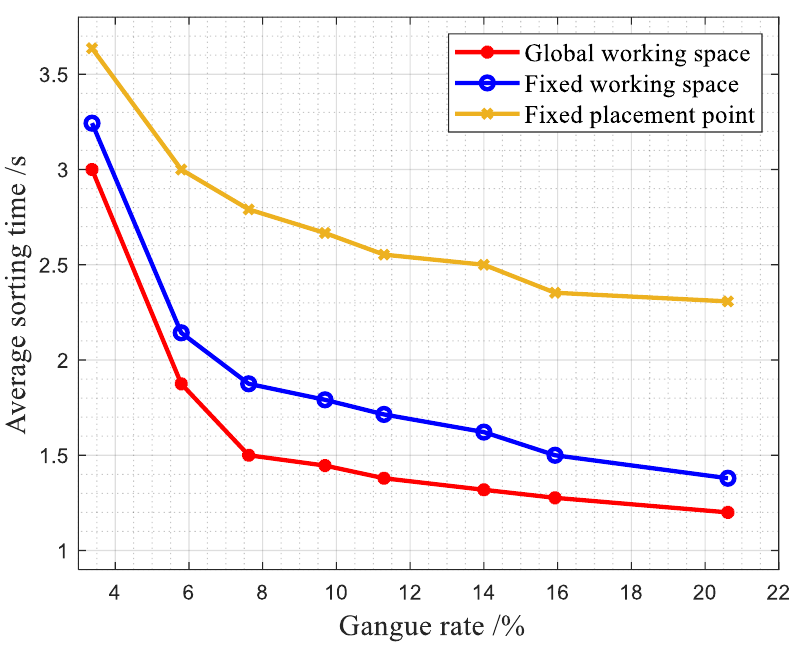
Figure 19. The average sorting time under the same belt speed with different gangue contents with a single arm.